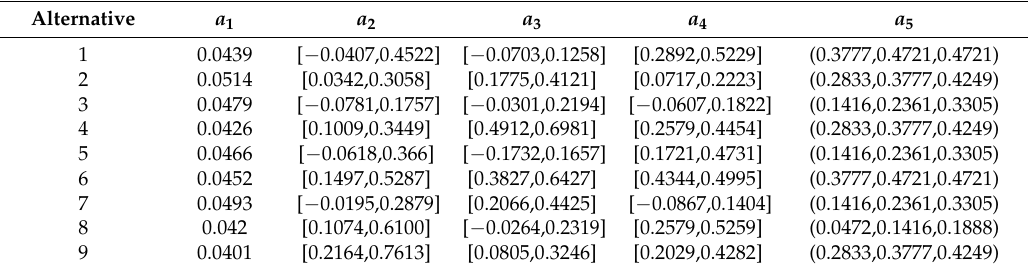
Table 4. Normalized decision matrix.